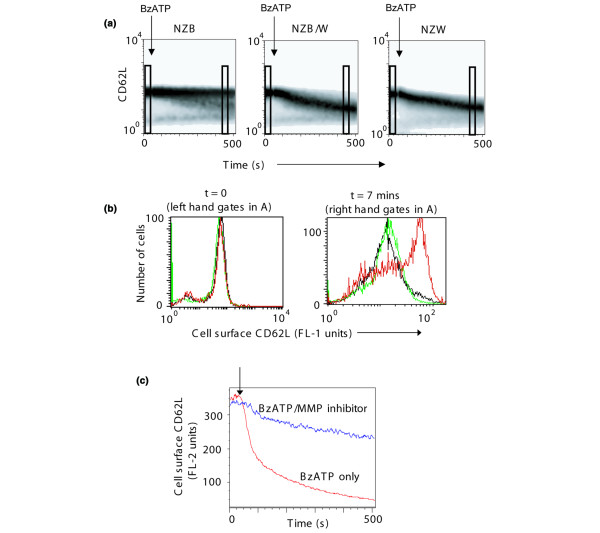
P2X7-stimulated shedding of CD62L by lymphocytes. To enable the direct comparison of responses of cells from New Zealand Black (NZB) mice, New Zealand White (NZW) mice and (NZB × NZW)F1 (NZB/W) mice in a single tube, lymphocytes from these strains were stained with anti-CD4PE, anti-CD4CYCHROME and anti-CD4APC, respectively, mixed and stained with anti-CD62LFITC. Thus labelled, cells could subsequently be distinguished by flow cytometric gating. Cells were stimulated with the P2X7 agonist 2'-3'-O-(4-benzoylbenzoyl)-adenosine 5'-triphosphate (BzATP) at the time indicated by the arrow in (a). (a) Density plots of the rate of CD62L shedding in each cell population, as indicated by decreased binding of anti-CD62LFITC. (b) Corresponding levels of cell surface CD62L in each population (NZB, red line; NZW, green line; NZB/W, black line) immediately preceding P2X7 stimulation (indicated by left-hand gates in (a)) or 7 min after P2X7 stimulation (indicated by right-hand gates in (a)). (c) Effect of a broad inhibitor of metalloproteinases on loss of CD62L. Lymphocytes from NZW mice were stained with anti-CD4CYCHROME and anti-CD62LPE, and the rate of loss of CD62L was assessed by flow cytometry. Cells were stimulated with BzATP in the presence or absence of 10 μM metalloproteinase inhibitor at the time indicated by an arrow. Shedding of CD62L is indicated by decreased binding of anti-CD62LPE. MMP, matrix metallopoteinase.